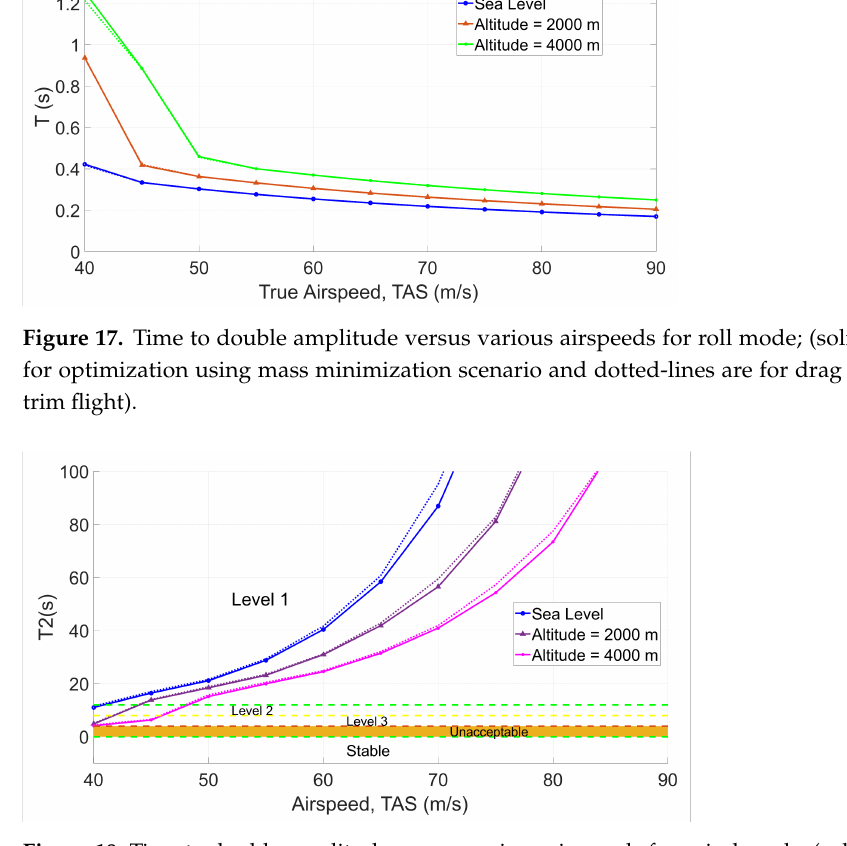
Figure 18. Time to double amplitude versus various airspeeds for spiral mode; (solid lines account for optimization using mass minimization scenario and dotted-lines are for drag optimization in trim flight). Similar to the aerodynamic characteristics, the results shown for the flight dynamic characteristics through Figures 12–18 reveal the same behavior for both optimization scenarios with the mass optimization and minimum drag optimization in the trim flight